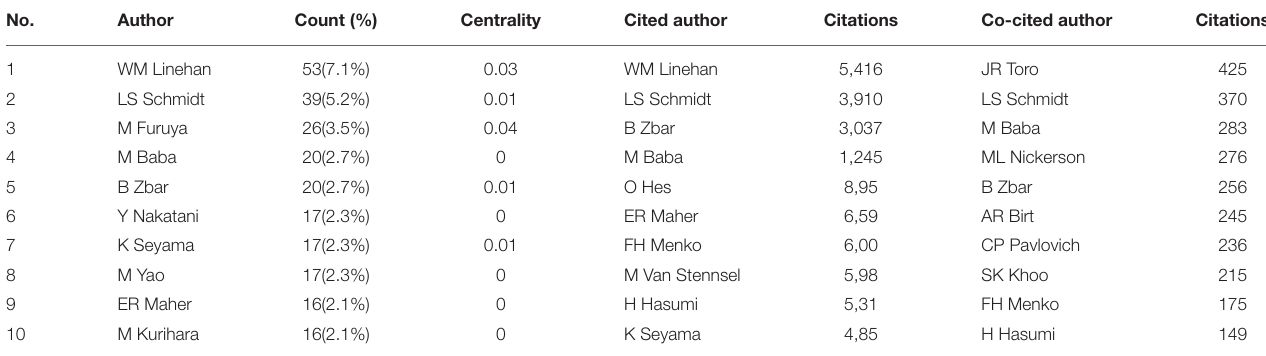
TABLE 4 | The top 5 authors, cited authors, and co-cited authors in BHD